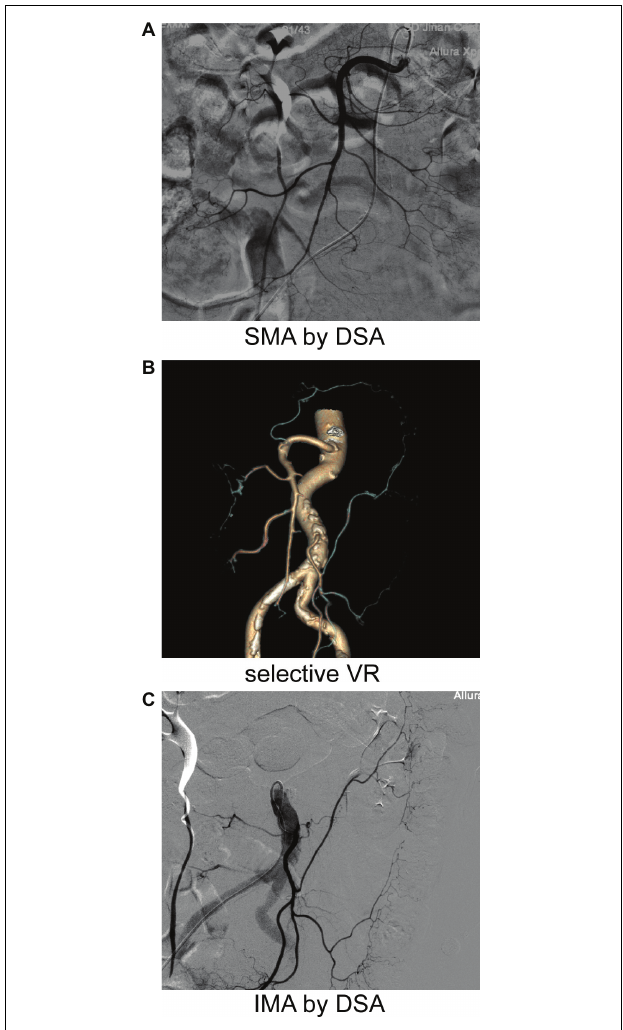
FIGURE 6 | DSA and CTA images from the same patient separately. The DSA was taken (A , C) after enhanced CT (B) in the same patient.